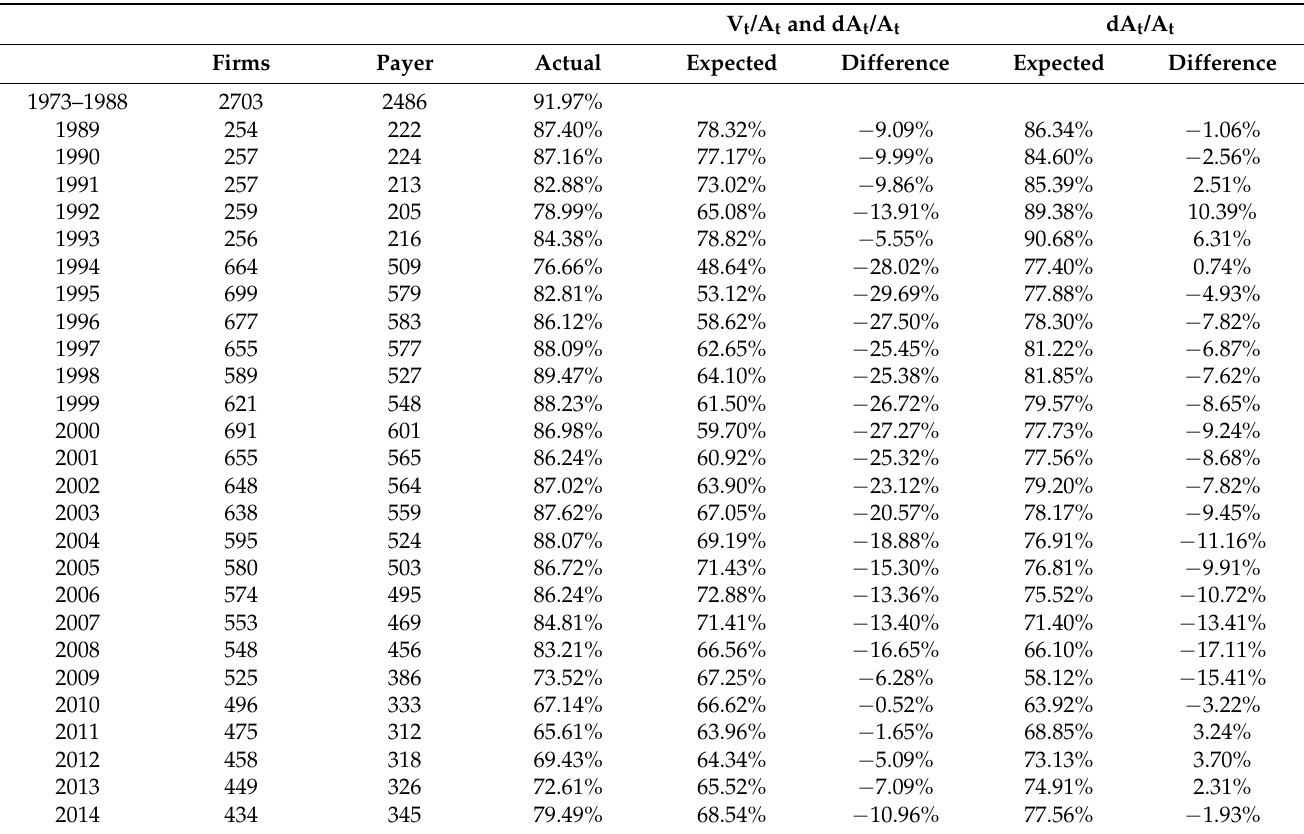
Table 4. Expected percentage of dividend payers versus actual payers based on baseline model. In this table, we apply the coefficients from the logit regressions in Table 3 estimated over the period 1973–1988 to the variable values in each year 1989–2014 to estimate the expected percentage of dividend payers in each year. We also show the actual percentage of dividend payers in each year to calculate the difference between the actual and expected percentages of dividend